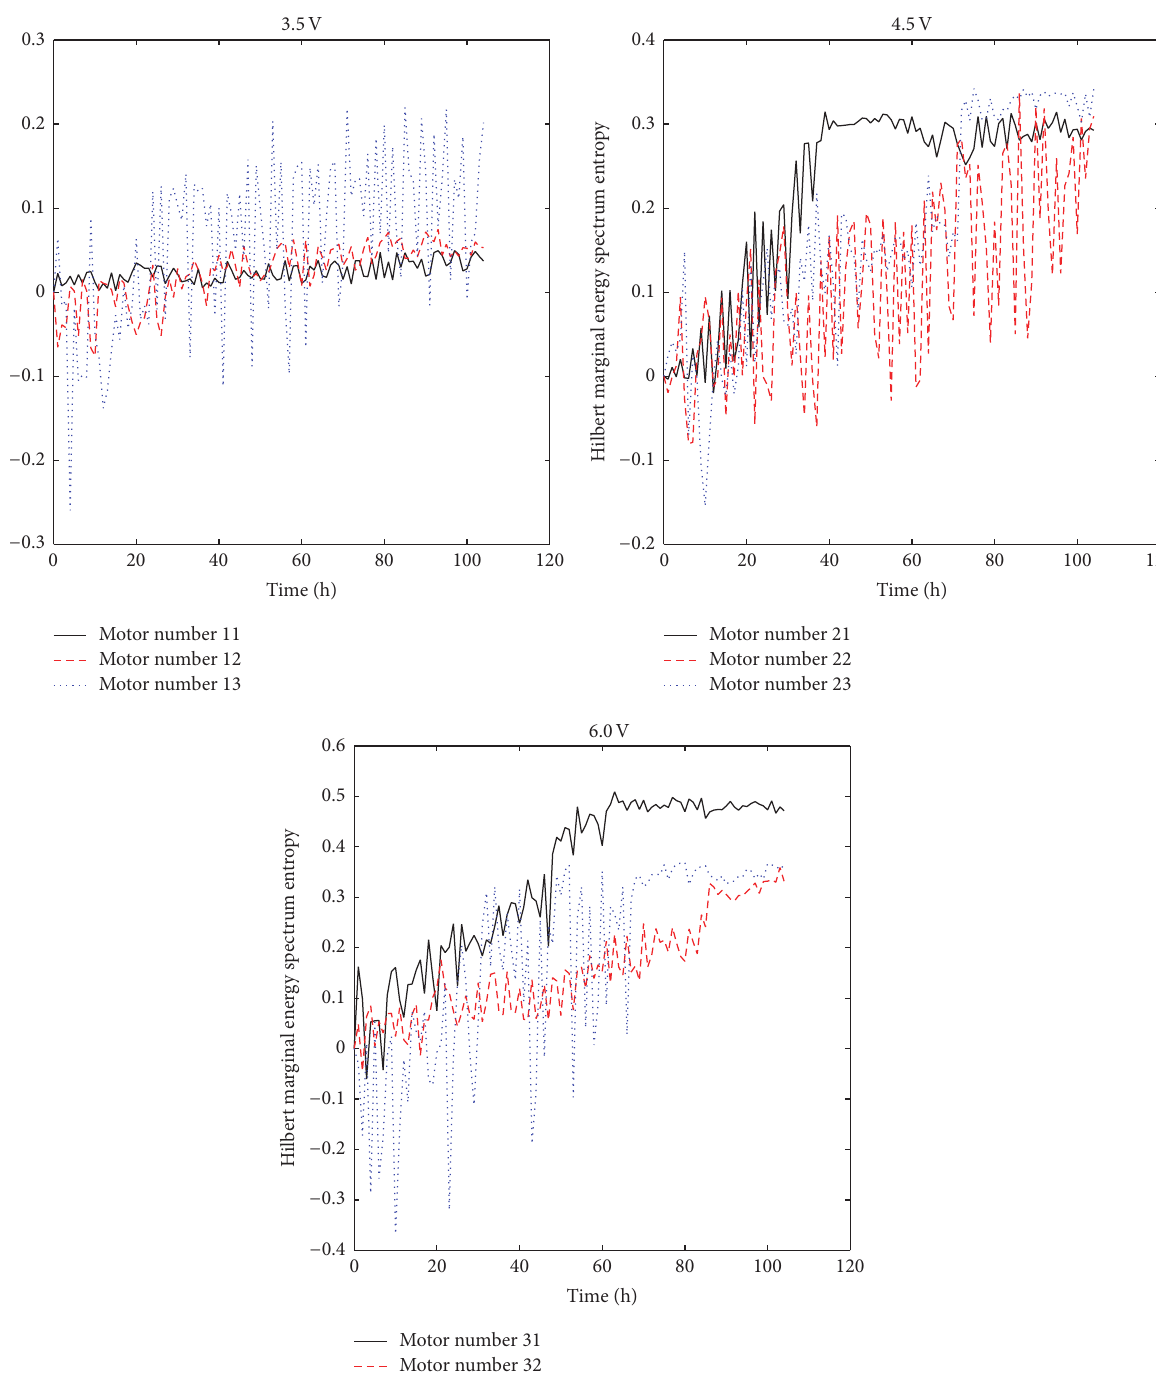
Figure 4: The CSADT data of Hilbert marginal energy spectrum